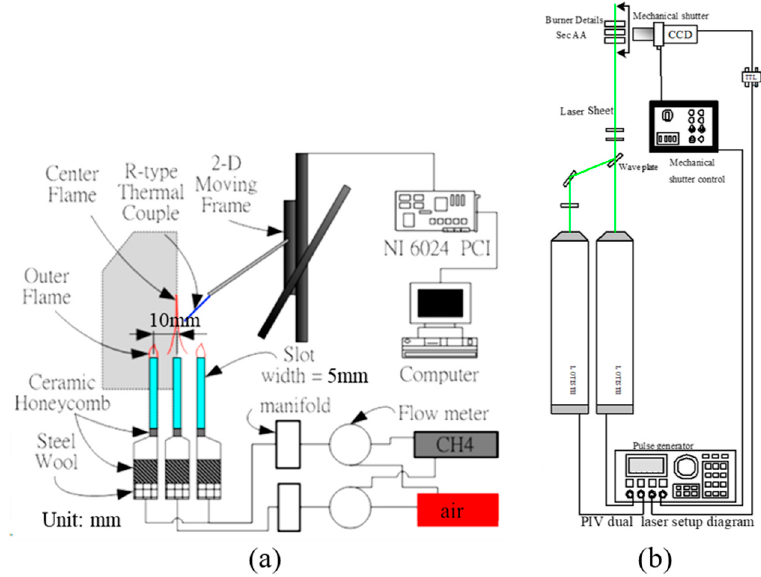
Figure 1. ( a ) Schematics of the triple-jet burner and experimental measurement set-up, and ( b ) essentials of combining the shuttered particle image velocimetry (PIV) system with high-speed video camera imaging.